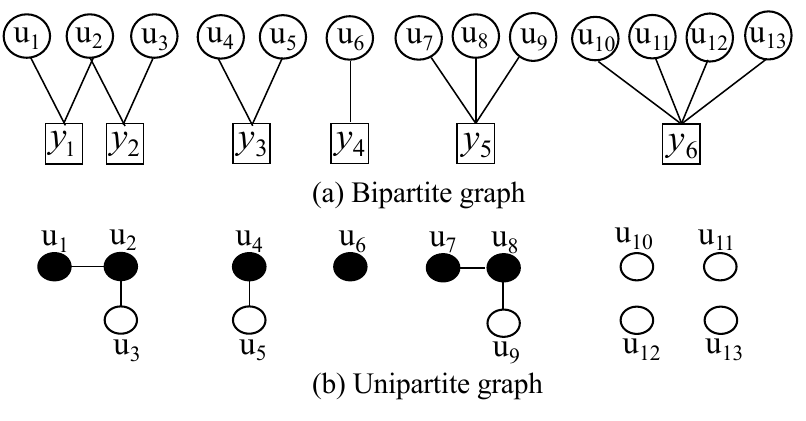
Figure 5. Active user states.